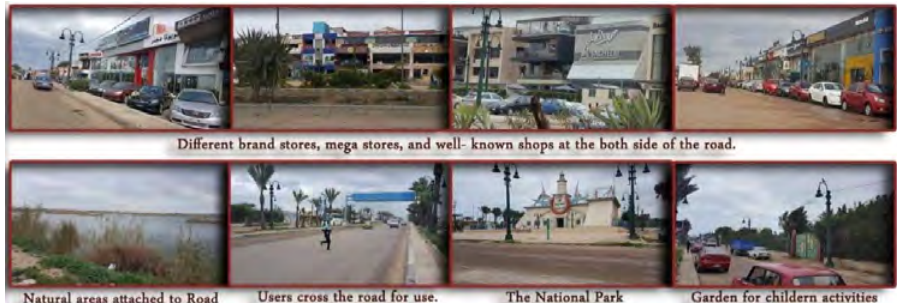
Figure 5. Facilities at the Suez Canal Road (Yoseph, 2017).